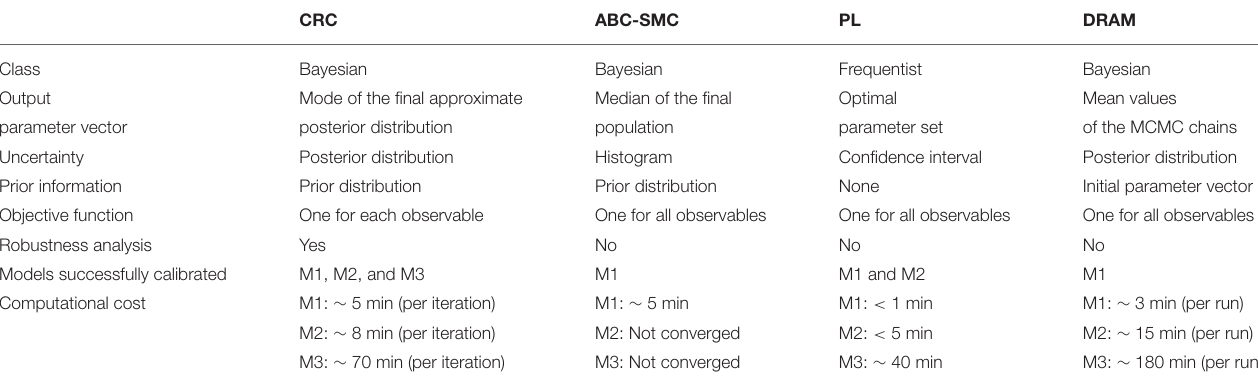
TABLE 6 | Comparison between parameter estimation